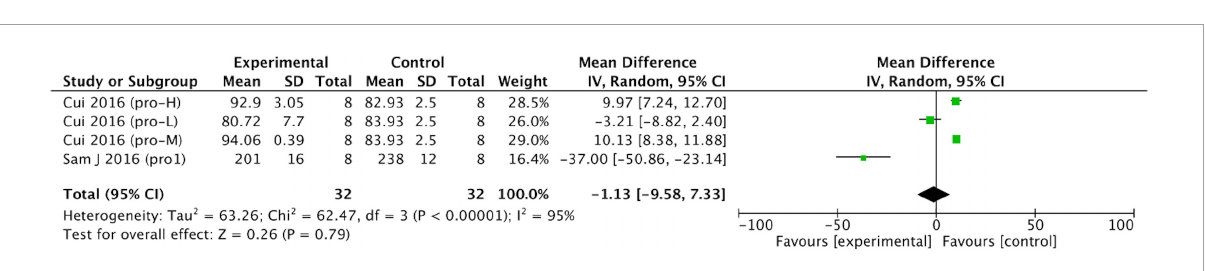
FIGURE7 Forest plot of the effects of soy protein (SD, standard deviation; CI, confidence interval; IV, inverse variance; µ